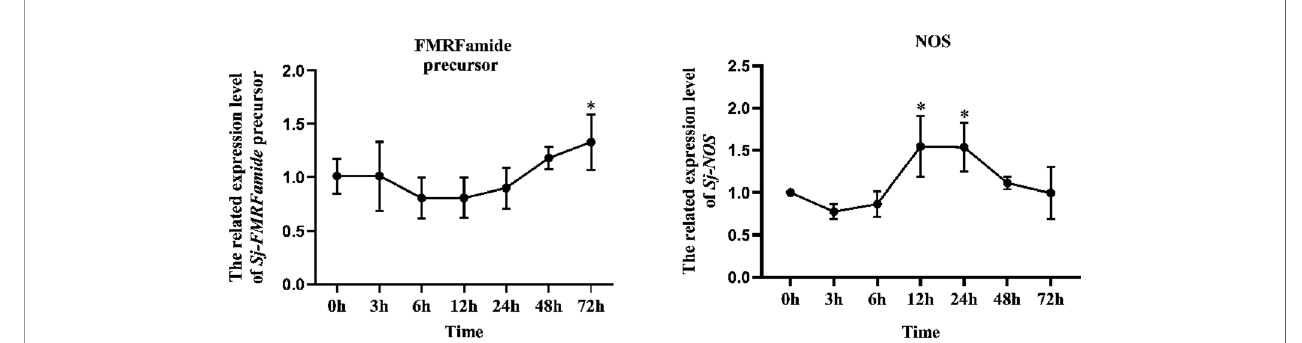
FIGURE 1 | Induction expression of FMRFamide precursor and NOS in cuttle fi sh larvae induced by Vibrio harveyi . Data were analyzed by a t-test that compared the treatment group at any given time to the blank group. One asterisk indicates a signi fi cant difference ( p < 0.05). NOS, nitric